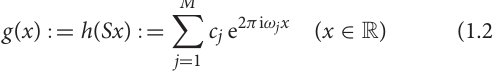
TABLE 1 | Numbers of required samples and computational costs for ESPRIT, MUSIC, and FFT, where M denotes the sparsity of (1.1) and S is a large even integer so that all frequencies ϕ j are of the form ω j ∈ ( − S 2 , S 2 ] ∩ Z